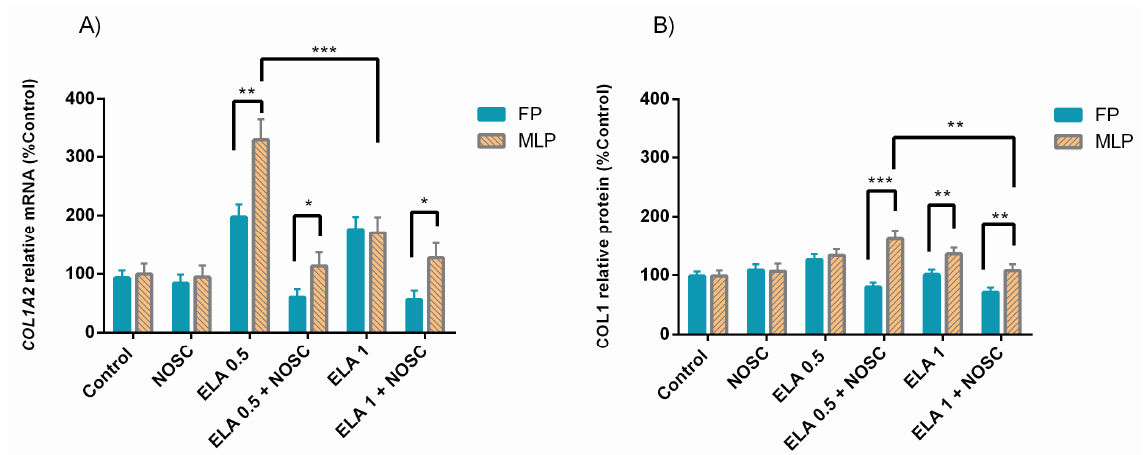
Figure 5. Effect of elastase (ELA; 0.5 or 1 µg/mL), noscapine (NOSC; 45 µg/mL), or ELA (0.5 or 1 µg/mL) + NOSC (45 µg/mL) treatments on relative collagen type I alpha 2 chain ( COL1A2 ) mRNA transcription ( A ) and collagen type I (COL1) protein relative abundance ( B ) in explants of mare endometrium from follicular (FP) or mid-luteal (MLP) phases, regardless of treatment time. Results are shown at least square means ± SEM and considered significant at p < 0.05. Asterisks above connecting lines indicate significant differences of the same treatment between estrous cycle phase (* p < 0.05; ** p < 0.01; *** p < 0.001).